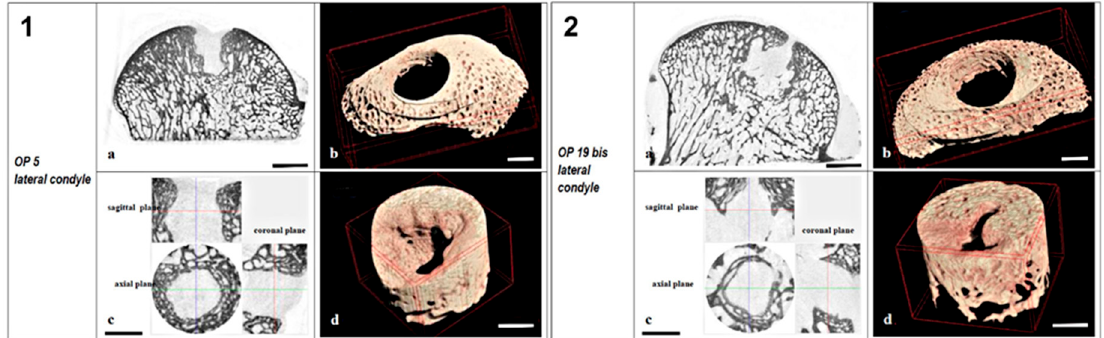
Figure 3. Micro-CT sections and 3D models of samples of control ( 1 ) and experimental group ( 2 ) in sheep. Each panel showed: ( a ) Condyle sagittal Micro-CT section, scale bar 5 mm; ( b ) 3D model of peri-implant trabecular bone in TV2, scale bar 3 mm; ( c ) micro-CT sections in axial, sagittal, and coronal planes of TV1, scale bar 3 mm; and ( d ) 3D model of the new bone formed into TV1, scale bar 3